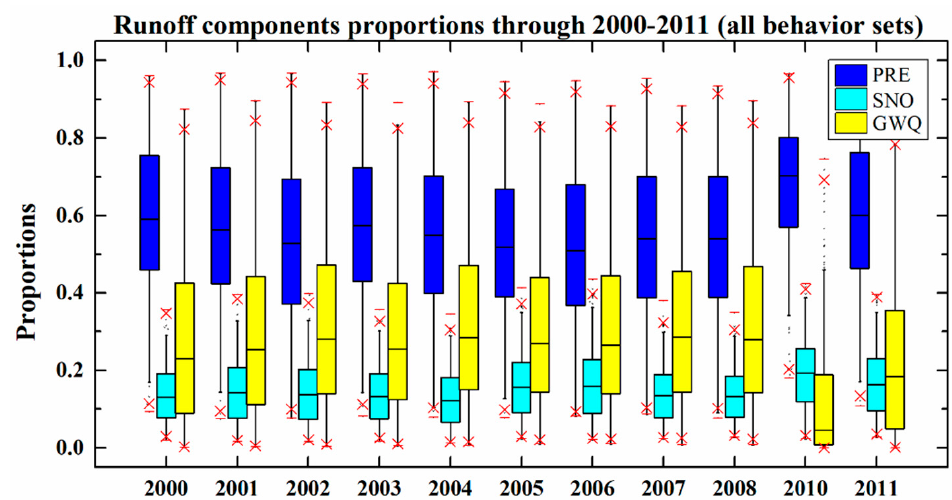
Figure 5. Proportions of runoff components from 2000 to 2011 derived from behavior simulations based on TRMM 3B42V7. GWQ stands for groundwater runoff, SNO stands for snowmelt runoff, and PRE stands for rainfall runoff. The red crosses wrap 98% of all data. The red short lines represent maximum and minimum values of all data. Black dots are outliners.